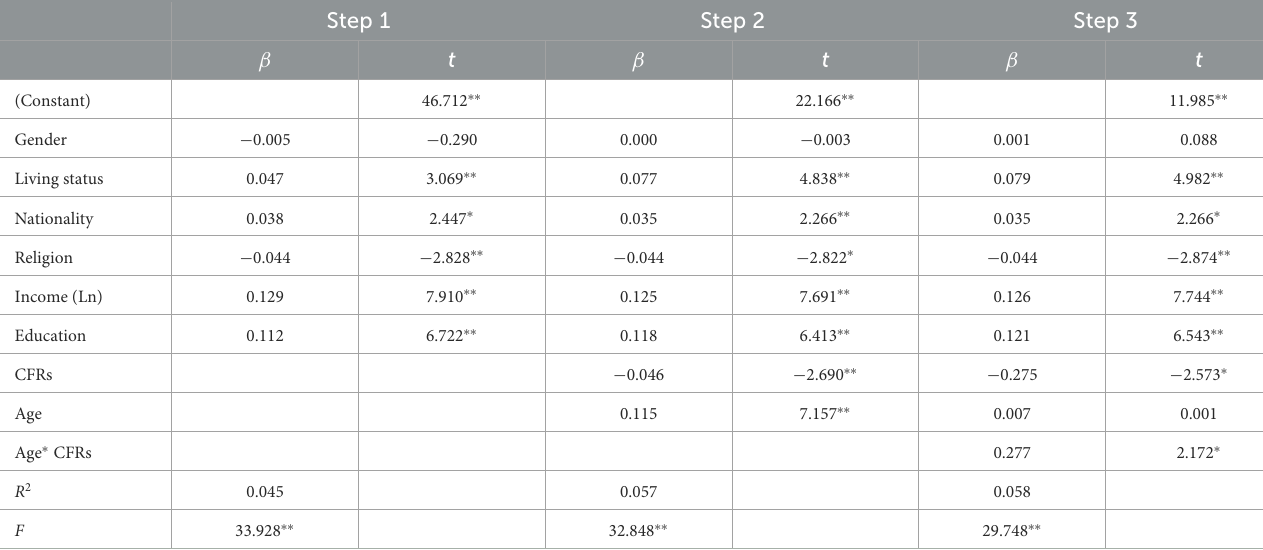
TABLE 3 Linear regression results of the effect on mental health.